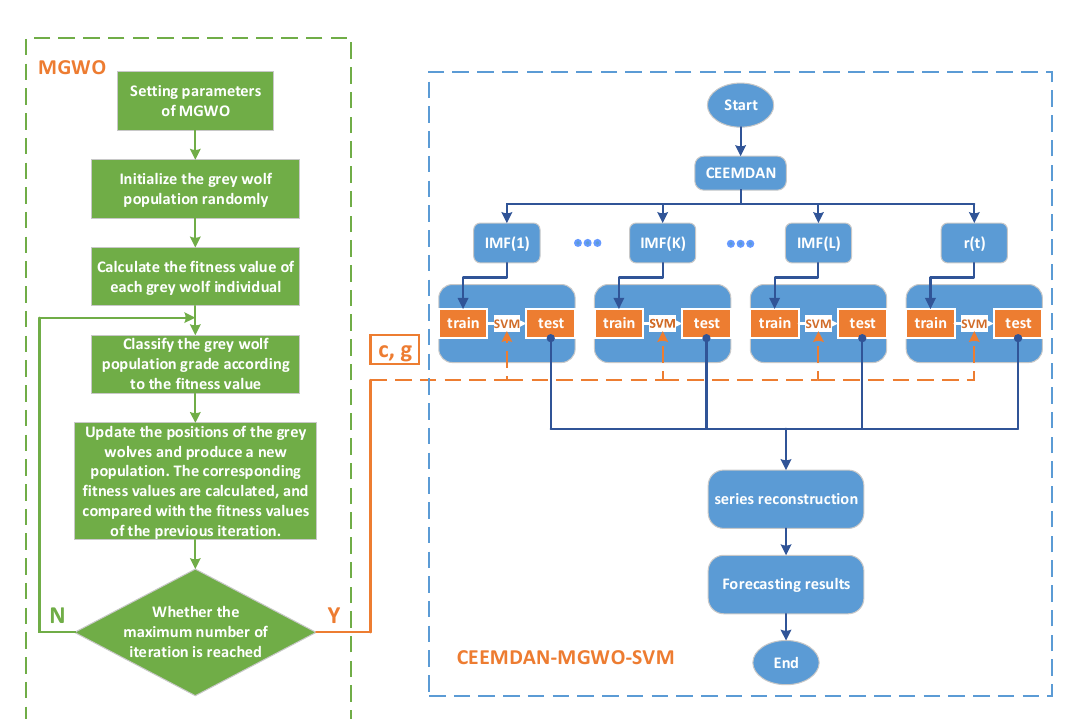
Figure 3. The flow chart of CEEMDAN ‐ MGWO ‐ SVM.